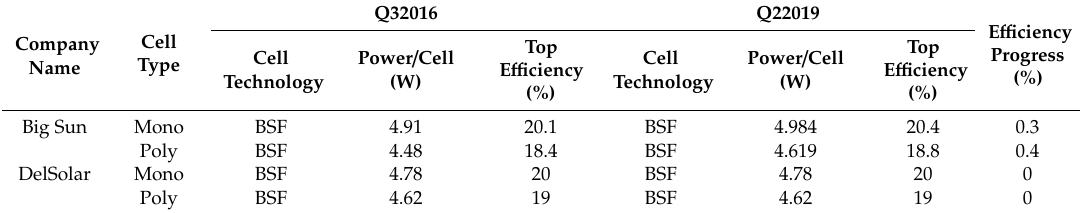
Table A1. c-Si cell product output over the period